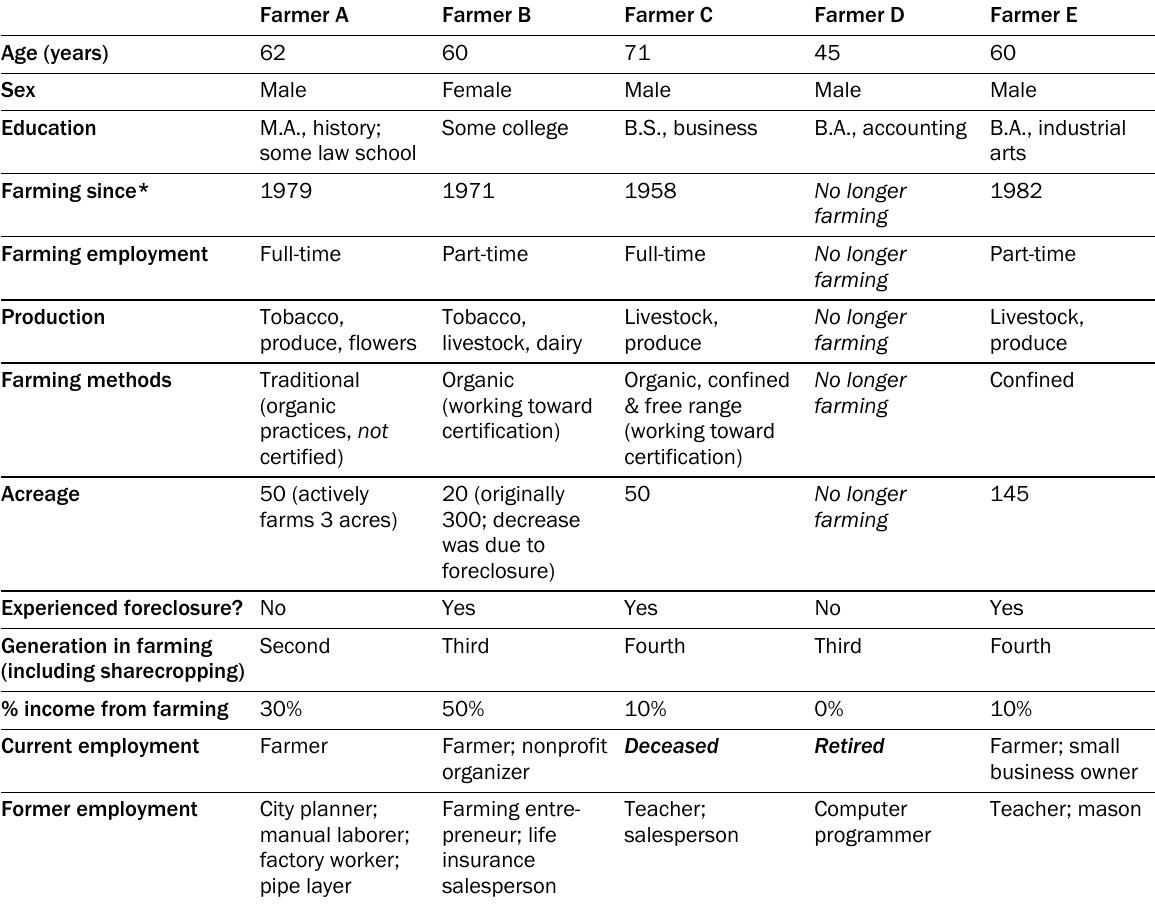
Table 1. Participant Demographics Related to